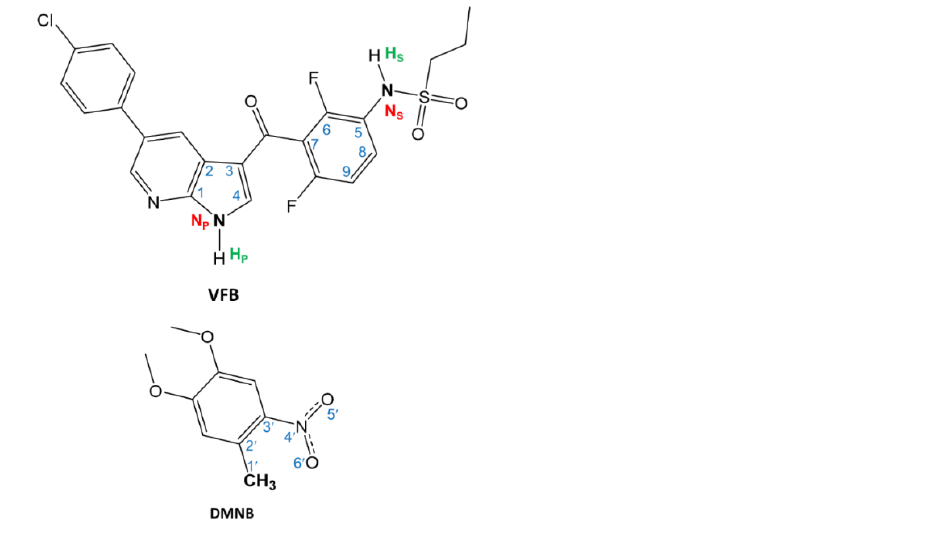
Figure 1. The chemical structures of vemurafenib (VFB) and 4,5-dimethoxy-2-nitrobenzene (DMNB).